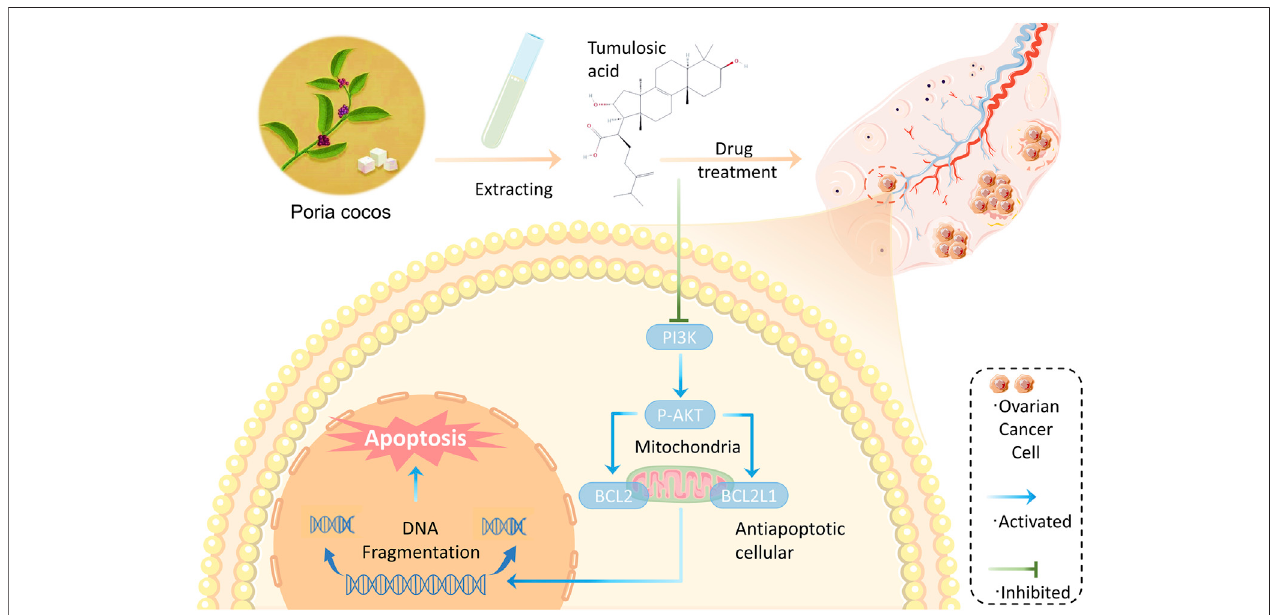
FIGURE 10 | Schematic diagram of tumulosic acid acting on PI3K/AKT signaling pathway to induce apoptosis of SKOV3 cells. Combining the network pharmacologyanalysisandourresults, wehypothesized thattumulosic acidin fl uencesthe PI3K/AKTsignaling pathway toregulate theexpression ofBCL2L1 toinduce apoptosis in ovarian cancer